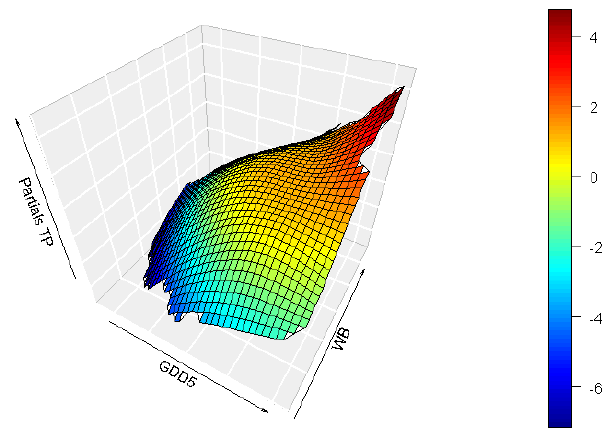
Figure 6. Partial effects of the tensor product (in m) of the interaction between WB and GDD5 on height of Norway spruce.